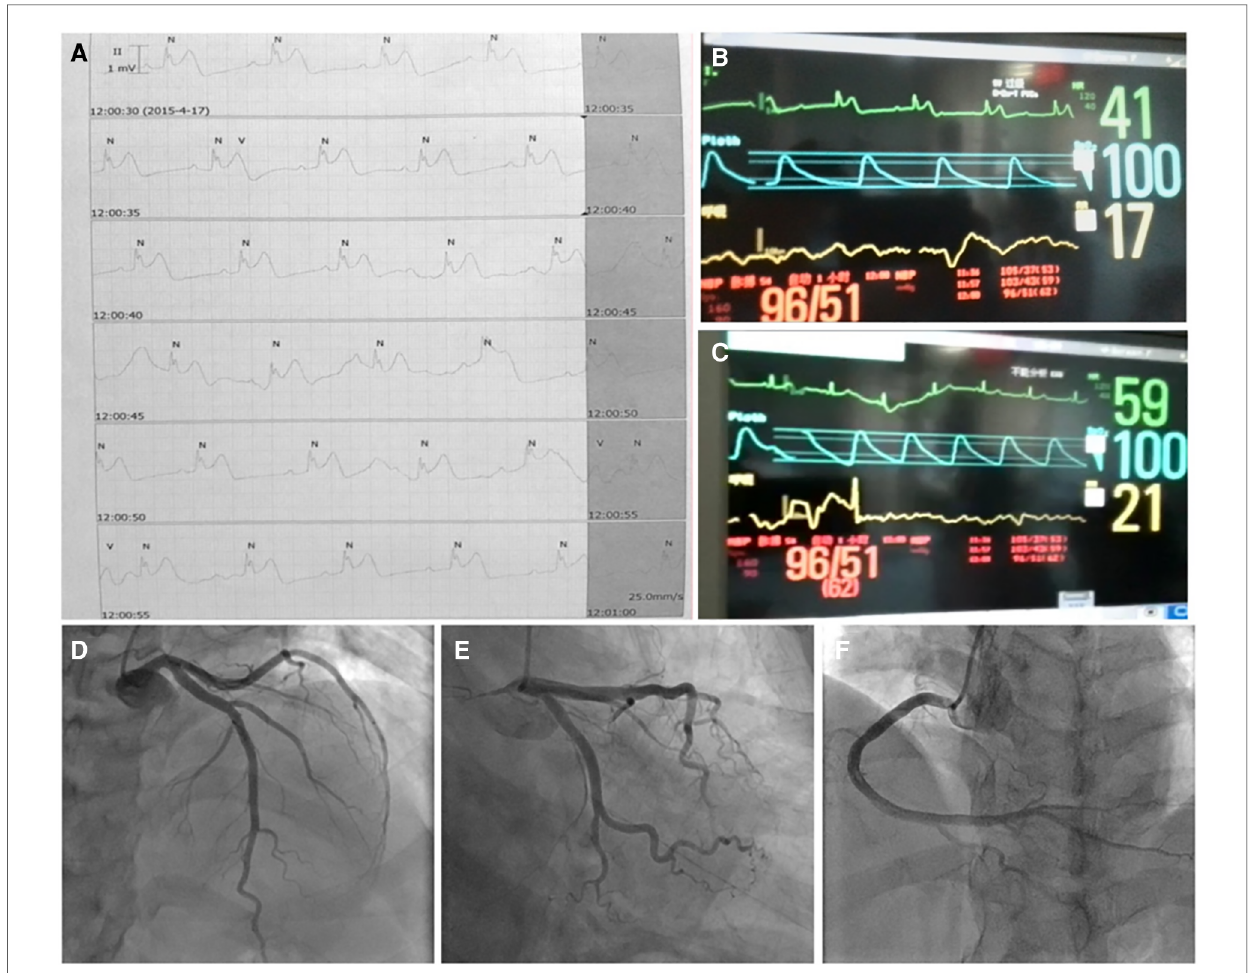
FIGURE 2 Twelve minutes after hospitalization, the chest pain recurred, and monitoring ECG revealed ST-T segments elevation in lead II and complete AV-B with HR 41 bpm accompanied by hypotension (BP 96/51 mmHg) ( A,B ). Five milligrams of diltiazem was administered intravenously with prompt relief of chest pain, and complete AV-B was converted back to sinus rhythm ( C ). Coronary angiography on day 2 revealed nonobstructive coronary arteries in the LAD, ( D ), LCX, or ( E ) RCA ( F ). ECG, electrocardiogram; AV-B, atrioventricular block; HR, heart rate; LAD, left anterior descending artery; LCS, left circum fl ex branch; RCA, right coronary